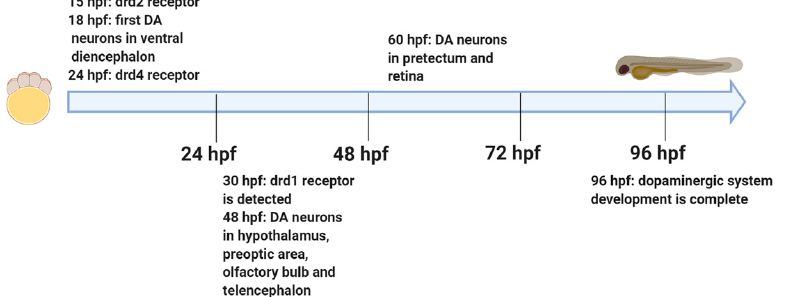
Figure 2. Developmental timeline of the dopaminergic system in zebrafish. DA: dopamine; drd1: dopamine receptor d1; drd2: dopamine receptor d2; drd4: dopamine receptor d4; hpf: hours post fertilization. Created with BioRender.com.